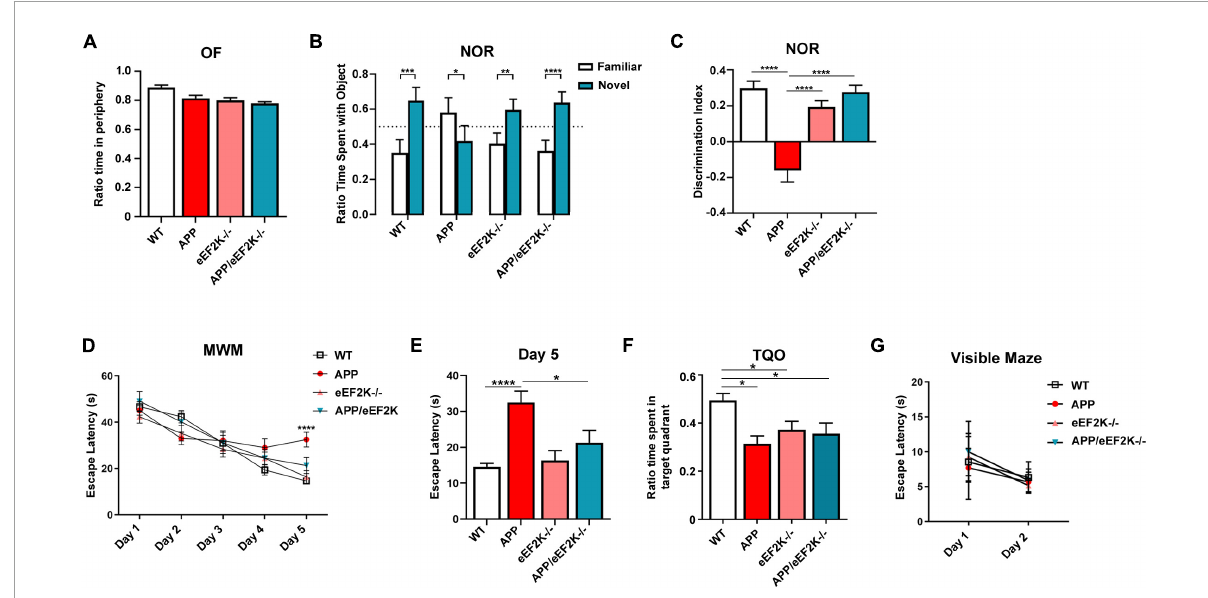
FIGURE2 Genetic suppression of eEF2K prevents AD-associated cognitive deficits in APP mice. (A) Ratio time spent in periphery in the OF task (WT, n = 17; APP, n = 9; eEF2K − / − , n = 10; APP/eEF2K − / − , n = 8). (B) Ratio time spent with familiar (white) and novel (blue) objects in the NOR task during testing phase (WT, n = 17; APP, n = 9; eEF2K − / − , n = 10; APP/eEF2K − / − , n = 8). Statistical preference for novel object: WT, ***p = 0.0002; APP, p = 0.822; eEF2K − / − , **p = 0.0014; APP/eEF2K − / − , ****p < 0.0001, unpaired t -tests. (C) Discrimination index [(time spent exploring novel object – time spent exploring familiar object)/total exploration time] (WT, n = 17; APP, n = 9; eEF2K − / − , n = 10; APP/eEF2K − / − , n = 8). WT vs. APP, **** p < 0.0001; APP vs. eEF2K − / − , **** p < 0.0001; APP vs. APP/eEF2K − / − , **** p < 0.0001, 1-way ANOVA with Tukey’s post hoc -test, F = 23.99. (D) Escape latency (s) over 5 days of training in the hidden platform MWM. Four trials/day (WT, n = 16; APP, n = 9; eEF2K − / − , n = 16; APP/eEF2K − / − , n = 9). WT vs. APP, **** p < 0.0001; APP vs. APP/eEF2K − / − , * p = 0.04, 1-way ANOVA with Tukey’s post-hoc test, F = 8.888. (E) Escape latency (s) on day 5 of MWM training (WT, n = 16; APP, n = 9; eEF2K − / − , n = 16; APP/eEF2K − / − , n = 9). WT vs. APP, **** p < 0.0001; APP vs. APP/eEF2K − / − , * p = 0.04, 1-way ANOVA with Tukey’s post-hoc test, F = 8.888. (F) Ratio time spent in target quadrant during probe trial phase of MWM (WT, n = 16; APP, n = 9; eEF2K − / − , n = 16; APP/eEF2K − / − , n = 9). (G) Escape latency (s) over 2 days in the visible maze task (WT, n = 16; APP, n = 9; eEF2K − / − , n = 16; APP/eEF2K − / − , n =